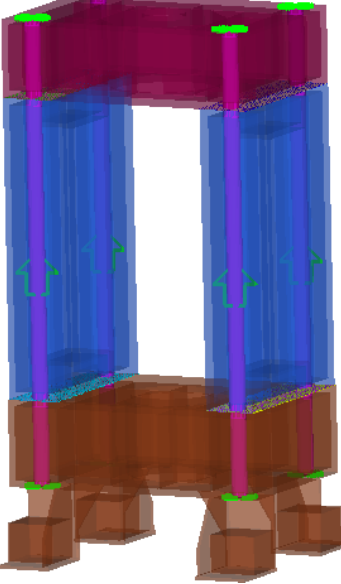
Figure 6. Frame model with pretightening